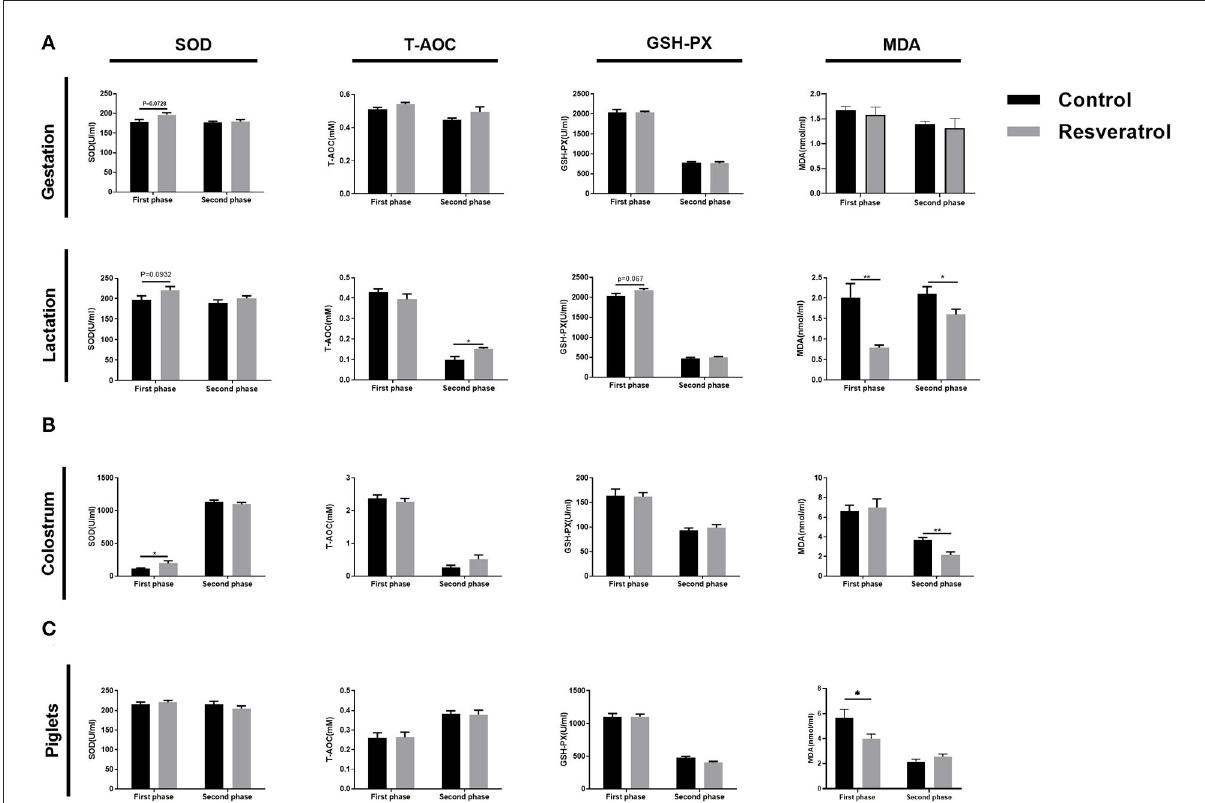
FIGURE3 (A) Effect of dietary resveratrol supplementation during gestation and lactation on the plasma antioxidant status of sows. (B) Effect of dietary resveratrol supplementation during gestation and lactation on the plasma antioxidant status of piglets. (C) Effect of dietary resveratrol supplementation during gestation and lactation on the antioxidant status of milk. Data were expressed as means ± SEM of at least three independent experiments. * p < 0.05, ** p < 0.01.